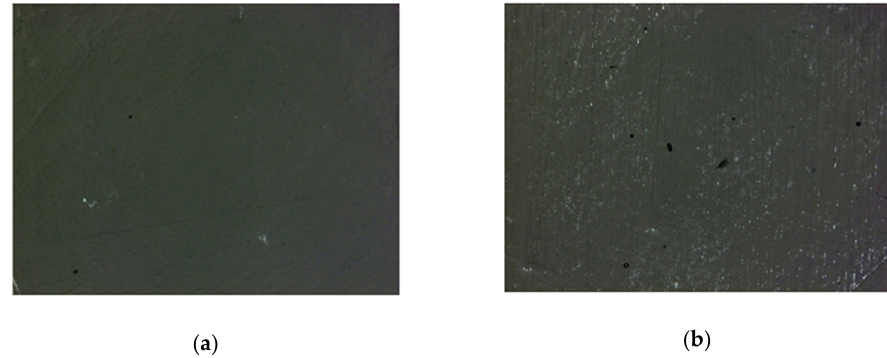
Figure 7. SEM diagrams at different molding temperature: ( a ) 680 °C; ( b ) 690 °C.